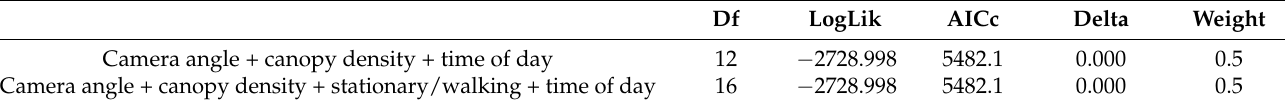
Table A2. The models with the best fit to the RGB data showing AICc and weight values.